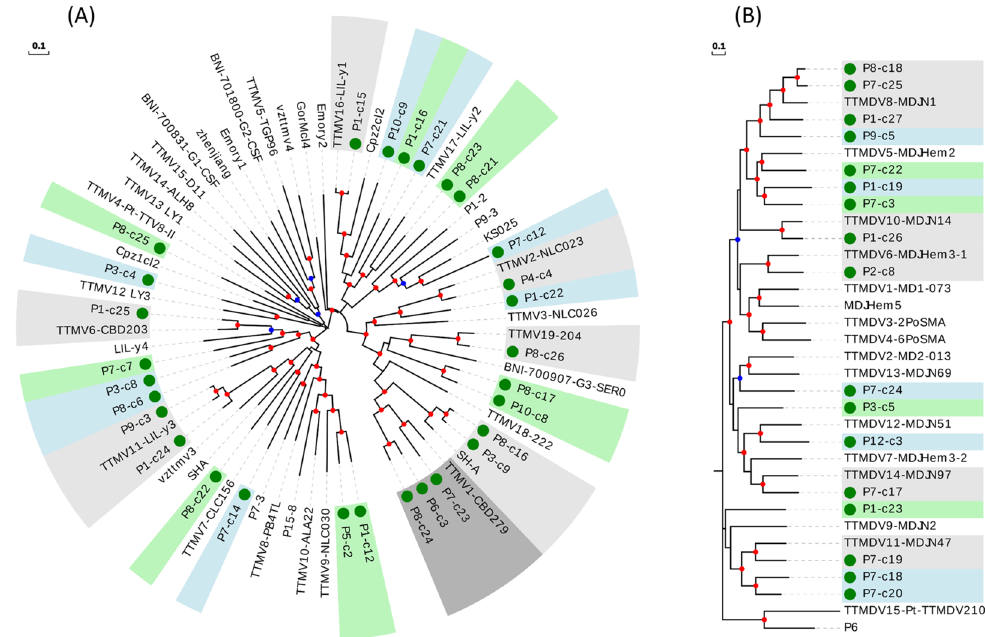
Figure 5. Phylogenetic trees for the ORF1 including the representative genotypes from TTMV ( A ) and TTMDV ( B ) genera. Sequences described in this study are marked with a green circle. New species (including one or more new sequences) are indicated with background green or blue color in order to distinguish contiguous clusters. Clusters of representative species including new sequences are indicated with background light or dark grey colors in order to distinguish contiguous clusters. 0.7–0.85 and 0.85–1.0 bootstrap value ranges are indicated with blue and red circles, respectively. Scale bar indicates evolutionary distance in nucleotide substitutions per